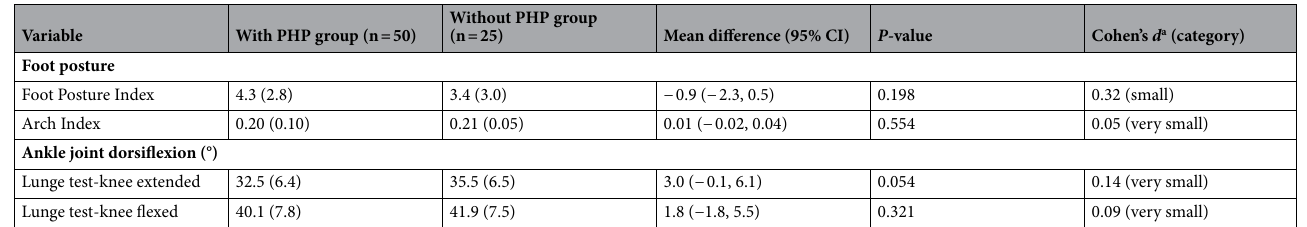
Table 2. Comparison of foot posture and ankle joint dorsiflexion between the PHP and control groups— values are means (SDs) unless otherwise stated. a Cohen’s d values were calculated by dividing the mean between-group difference by the average of the standard deviations for both left and right foot data, and interpretations were taken from Sawilowsky 45